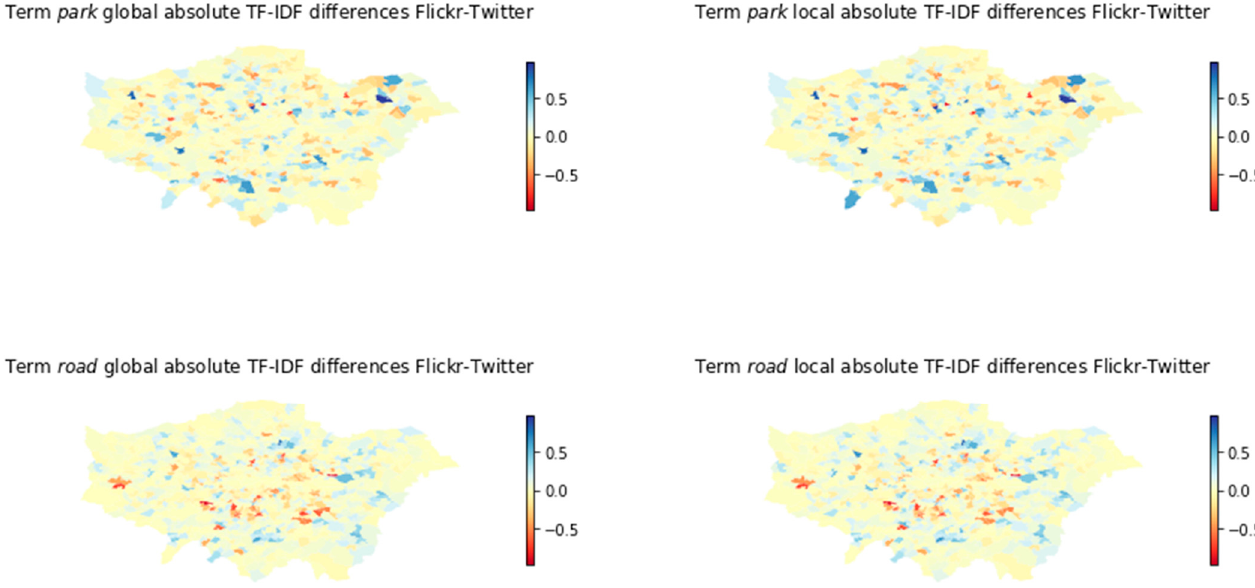
Figure 1. The absolute global and local TF-IDF score differences between Flickr and Twitter for road and park.